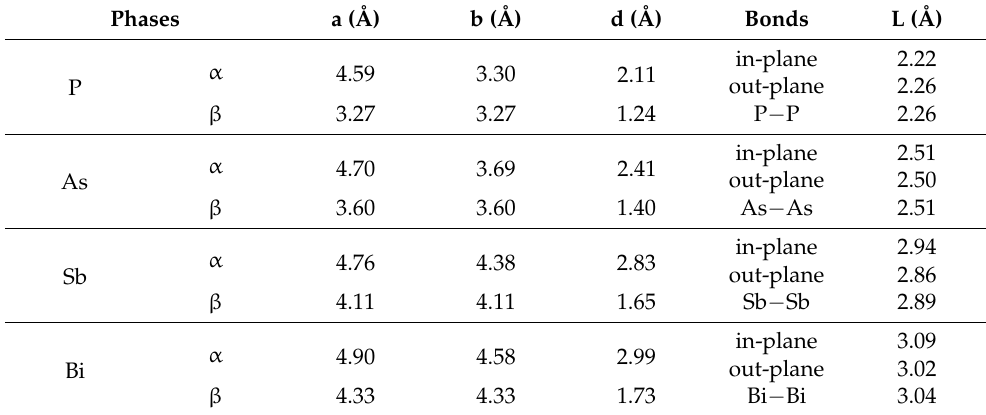
Table 1. Structural parameters of all group-VA 2D monolayers. a and b are the lattice constants, d is the thickness of the monolayer, and L denotes the bond lengths.